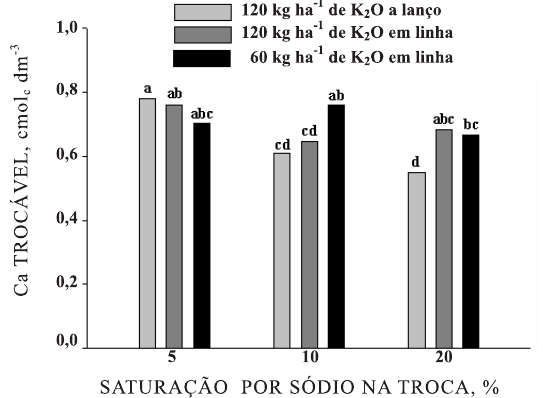
Figura 1. Teor de cálcio trocável no solo em função do manejo da adubação potássica e de níveis de salinidade no solo. Médias seguidas pela mesma letra não diferem entre si pelo teste DMS, a 5